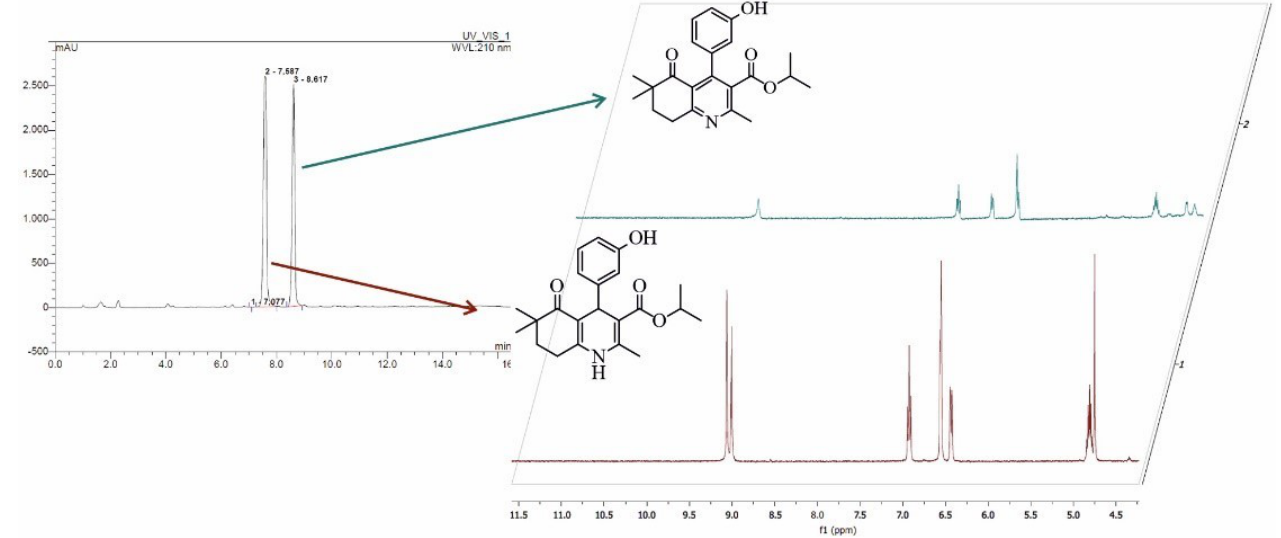
Figure 4. HPLC chromatogram of the laccase mediated transformation of DHP1 showing both DHP1 and DHP1-R as reaction product and 1 H NMR spectra of the DHP1 (bottom) and its tetrahydroquinoline derivative as the isolated oxidation product (top).